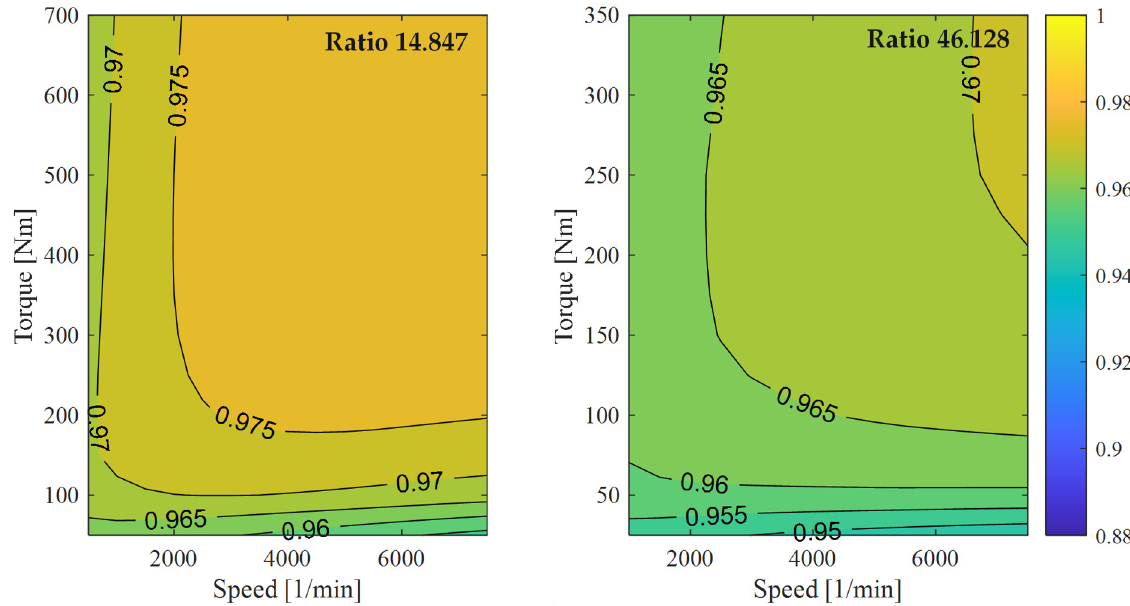
Figure 5. Simulative efficiency maps of the switchable gear stage of EM2 from Concept ELV 2 .